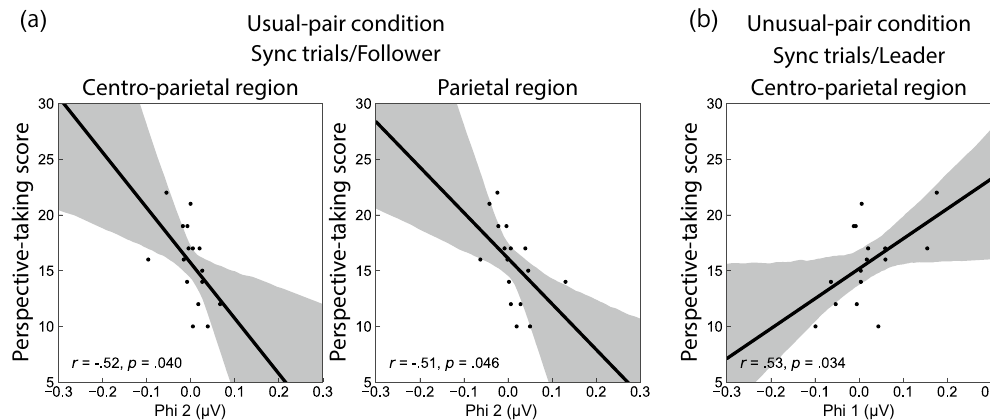
Figure 3. Scatter plots of correlations between changes in the phi complex (from control to sync trials) and PT scores of the IRI. These scatter plots indicate the relation between the individual PT ability and the individual magnitude of the phi complex. ( a ) The two plots represent the correlation between PT scores and phi 2 in followers during movement synchronization in the usual-pair condition. ( b ) The plot represents the correlation between PT scores and phi 1 in leaders during synchronization movements in the unusual-pair condition. Grey shaded areas represent 95% confidence intervals. IRI interpersonal reactivity index, PT perspective-taking.